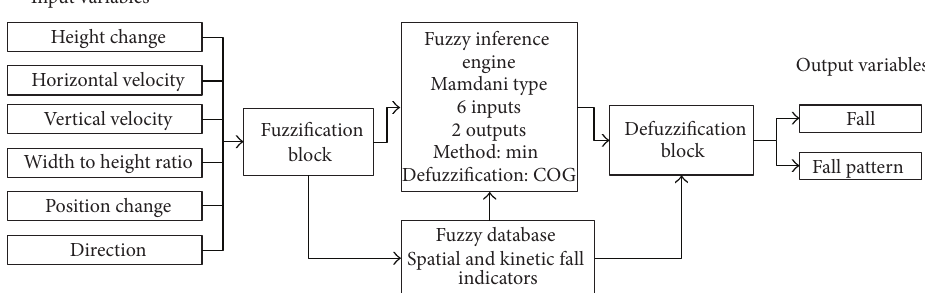
Figure 2: Fuzzy inference system for fall patterns recognition.